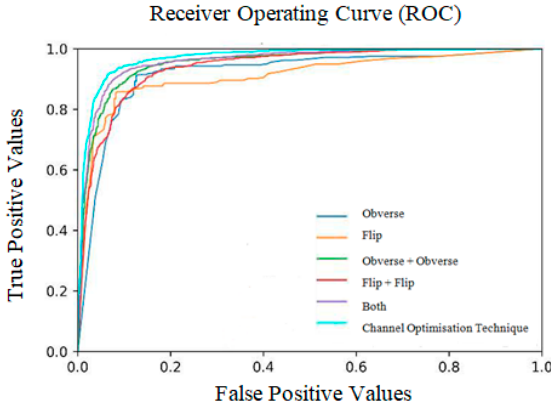
Figure 10. Receiver operating curves (ROC).